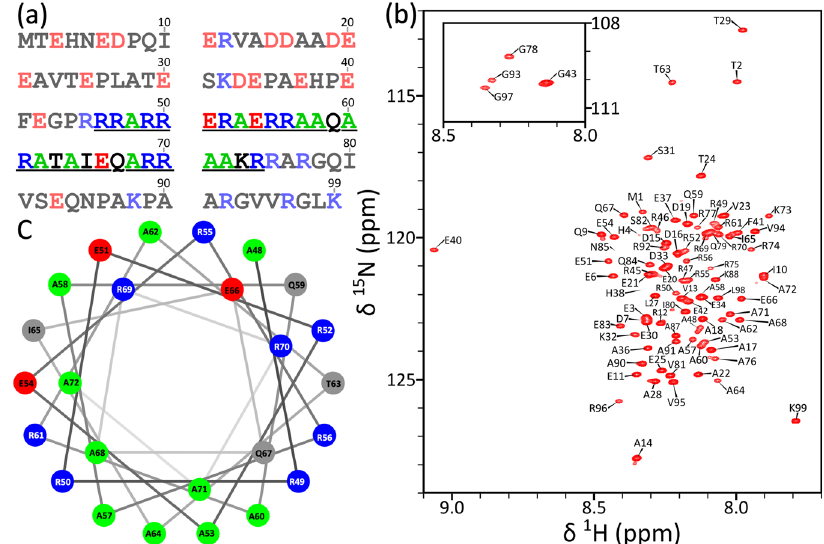
Fig. 1 Sequence and conformational properties of FtsQ1-99. a The amino-acid sequence. The helical region is underlined, with Ala residues therein in green; acidic and basic residues are shown as red and blue, respectively, throughout the sequence. b 1 H- 15 N HSQC spectrum of uniformly 13 C- 15 N-labeled FtsQ1-99 at 370 μ M, acquired at 800 MHz and 305 K in 20 mM Tris (pH 6.85) with 50 mM of NaCl. c Helical wheel representation for core helical residues 48 – 72. Acidic, basic, Ala, and other residues are shown in red, blue, green, and grey, respectively. Arg49 and Arg50 de fi ne a 100° arc, in which Ala53, Ala57, Ala60, Ala64, and Ala71